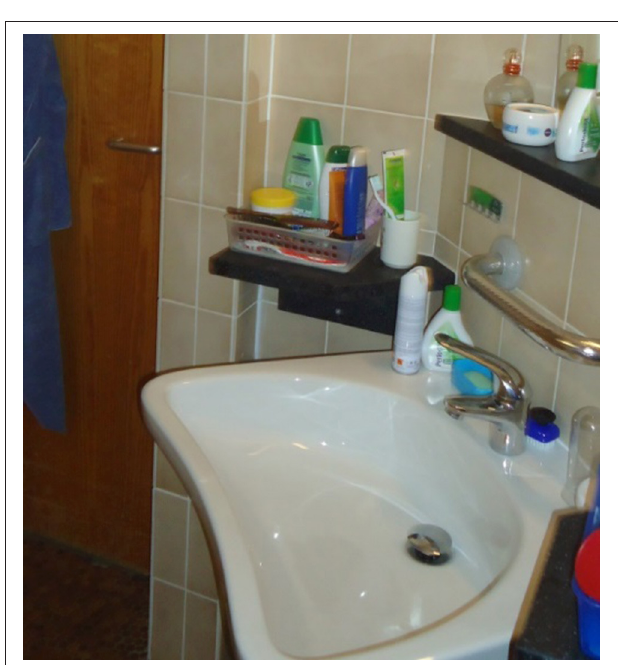
FIGURE 3 | A shared private bathroom of two residents, taken by Artner